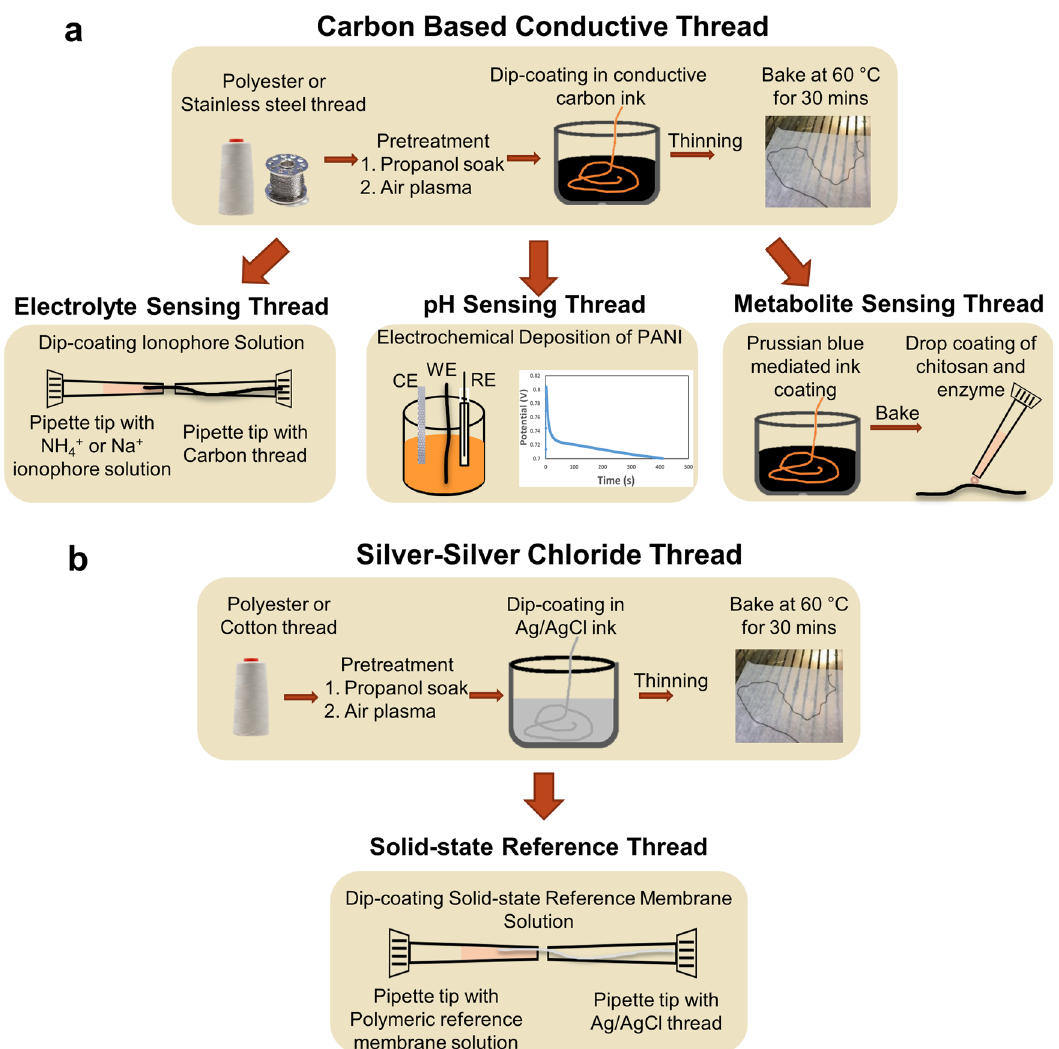
Fig. 2 Construction of thread-based sensing and reference electrodes. Steps in preparation of a carbon-based conductive threads and sensing threads and b PVB-coated Ag/AgCl/PE